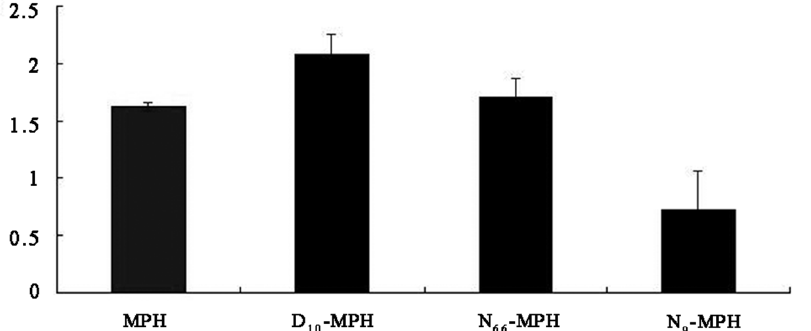
Figure 5. Analysis of mph mRNA levels. The expression of the recombinant cDNAs was assessed by quantitative real-time PCR, using GAPDH for normalization. Data are expressed as the means of duplicate samples, and error bars indicate standard deviation (SD).